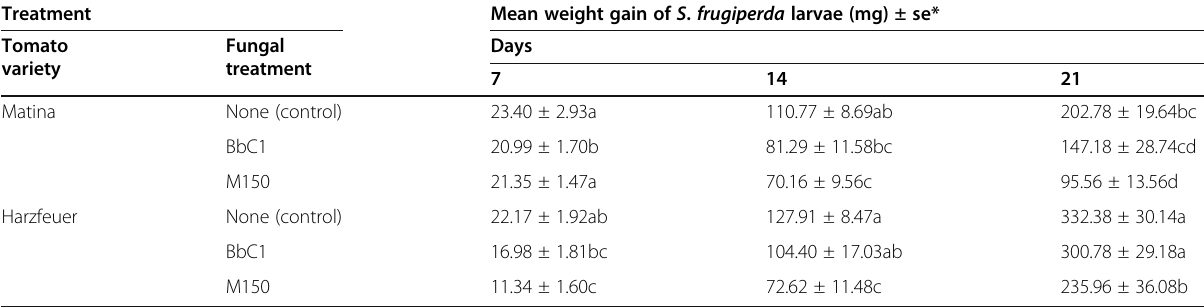
Table 2 Weight gain of Spodoptera frugiperda larvae feeding on root-inoculated tomato varieties (Harzfeuer and Matina) either with Beauveria bassiana (BbC1 ) or with Metarhizium anisopliae (M150) for 21 days Treatment